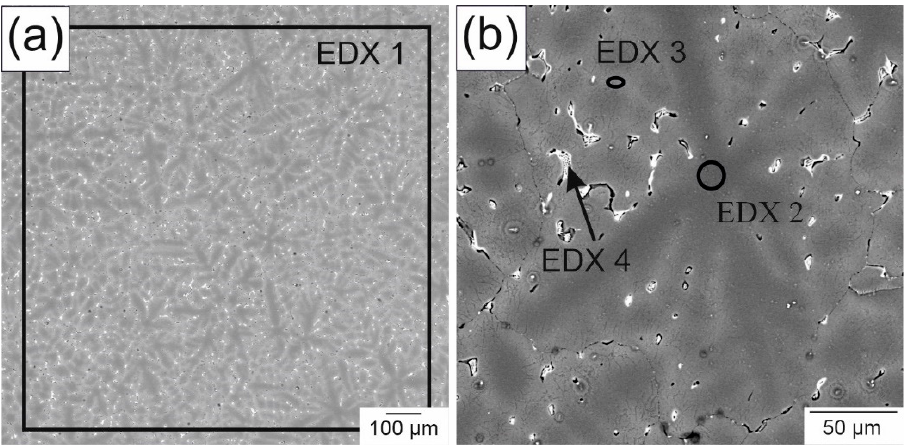
Figure 6. Backscattered electron images of as-cast WE 43 with ( a ) low and ( b ) high magnification. Table 3. Results of the EDX measurements indicated in Figure 6.